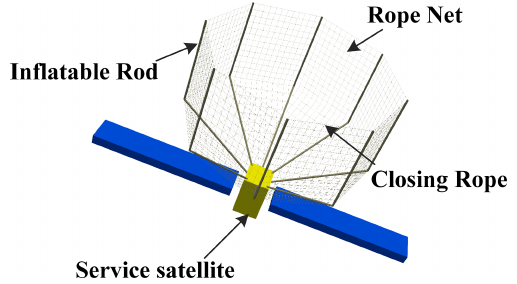
Figure 2. Space netted pocket system composition.